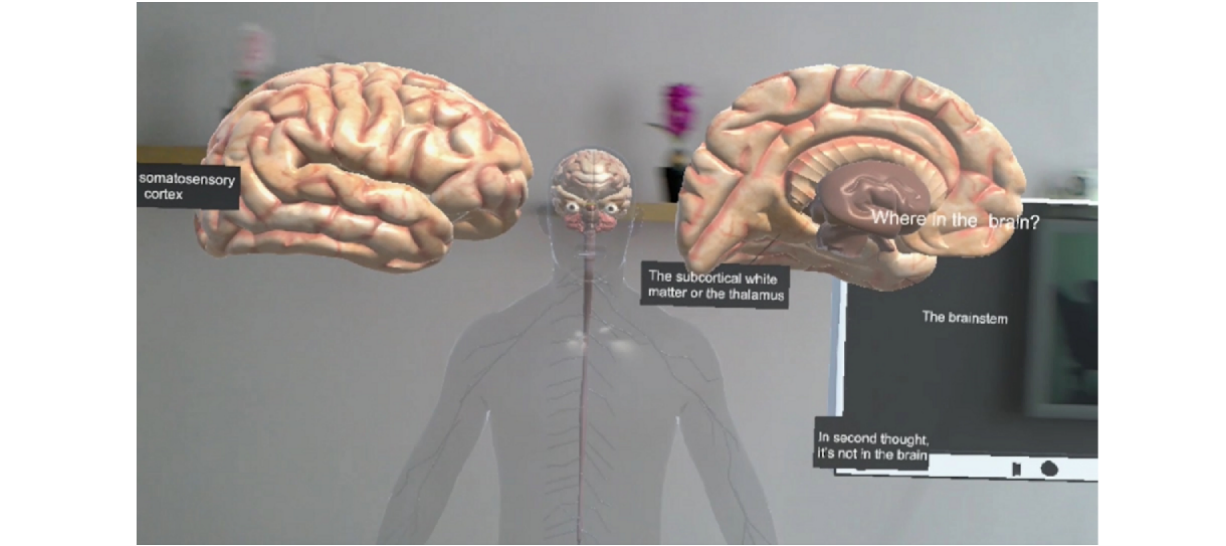
Figure 1. Part of the HoloAnatomy neuroanatomy virtual scenario.